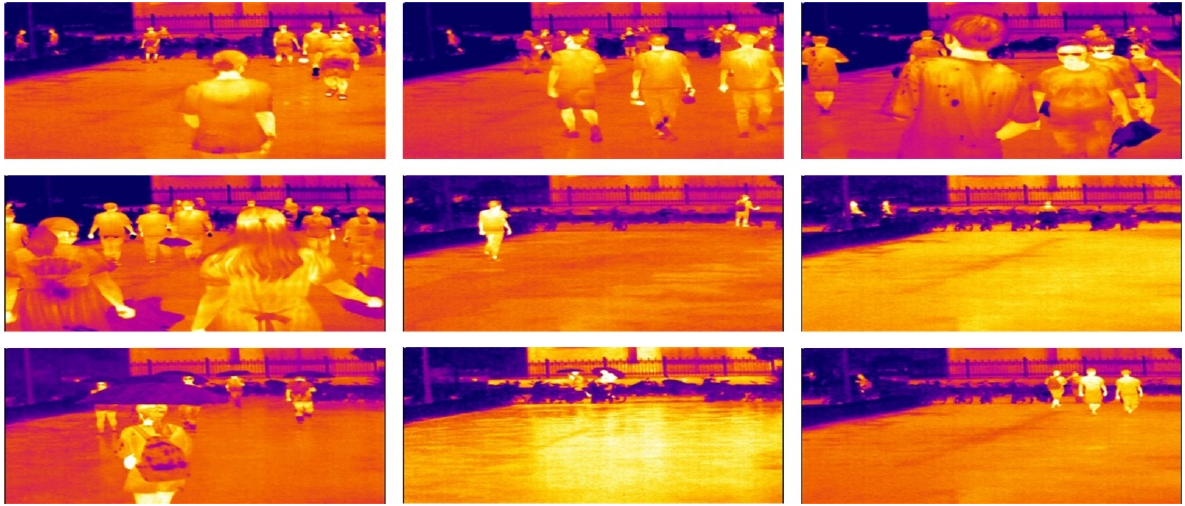
Figure 6. YDTIP dataset visualization results.